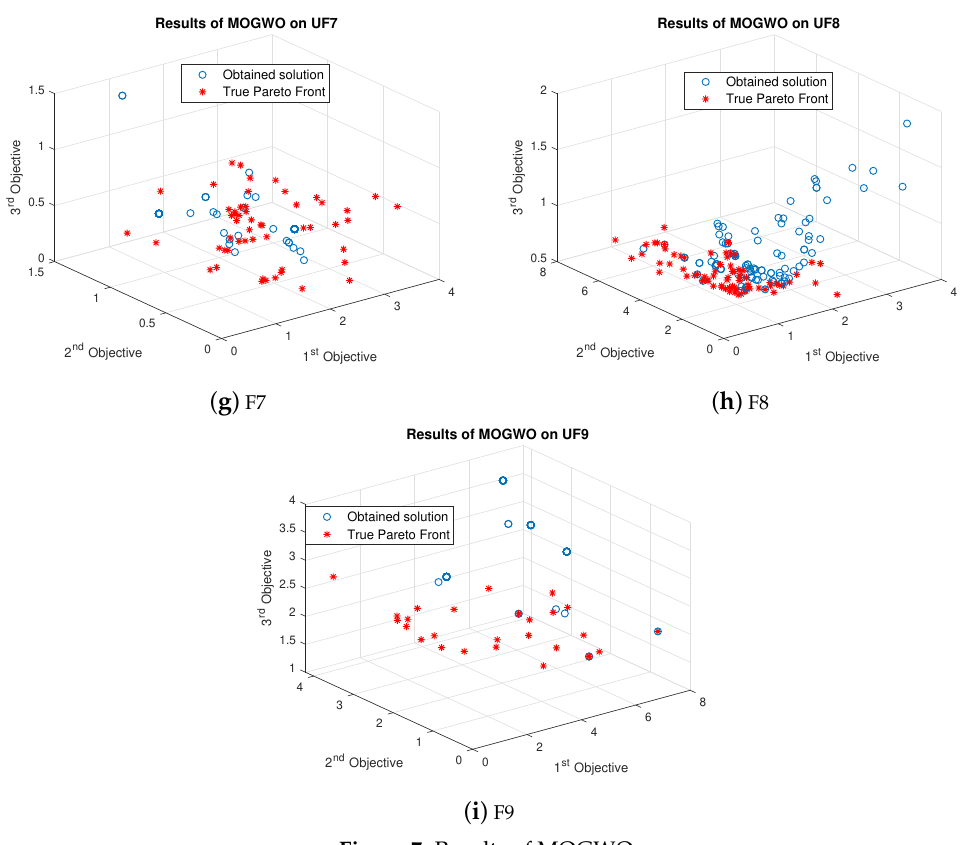
Figure 7. Results of MOGWO.